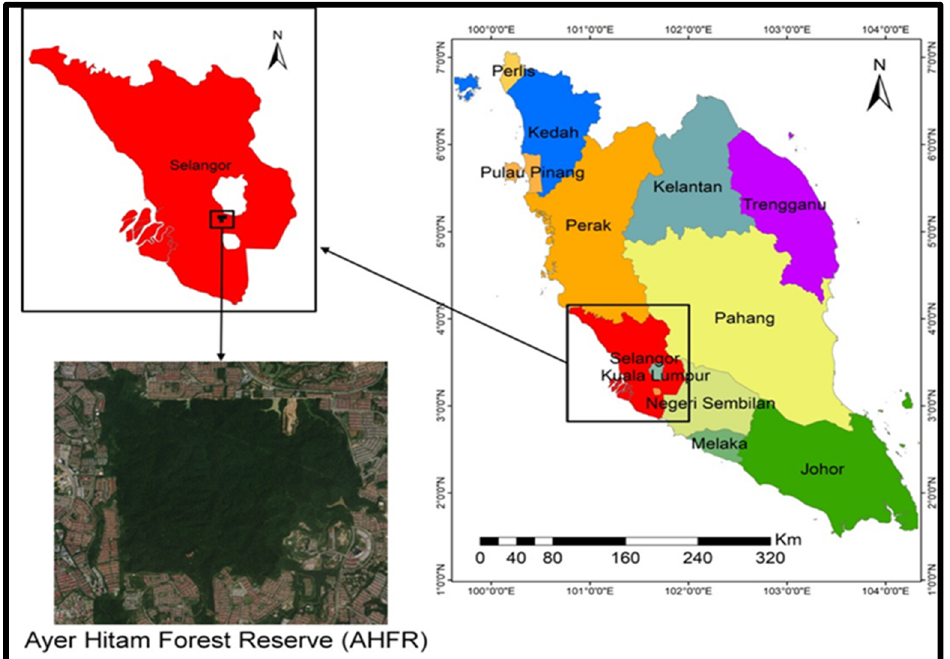
Figure 2. Location of Ayer Hitam Forest Reserve (AHFR), Puchong experimental farm, Universiti Putra Malaysia (UPM), Serdang, Selangor, Malaysia [49].